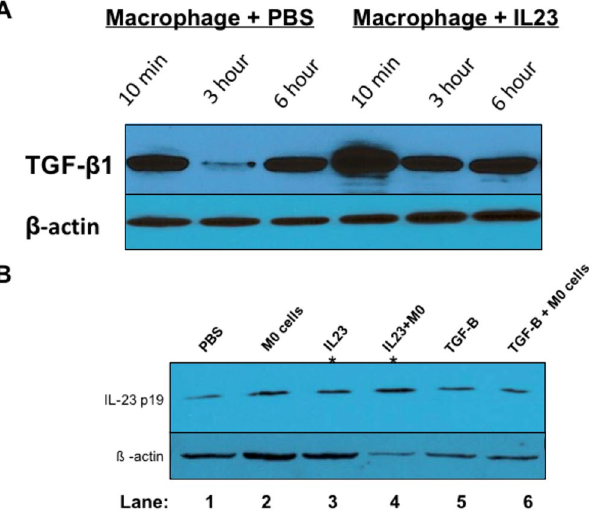
Figure 3. Relationship between IL23 and TGF-ß protein expression in vitro . We found that IL23 transiently increases TGF-ß1 expression in a macrophage cell line ( A ). IL23 is slightly increased in Panc-1 cells after macrophage exposure, TGF-ß treatment, and TGF-ß + macrophage treatment (Lanes 2, 5, and 6 in B, respectively) compared to PBS treated Panc-1 cells (Lane 1) and IL23 treated Panc-1 cells (lanes 3 & 4, positive controls marked *